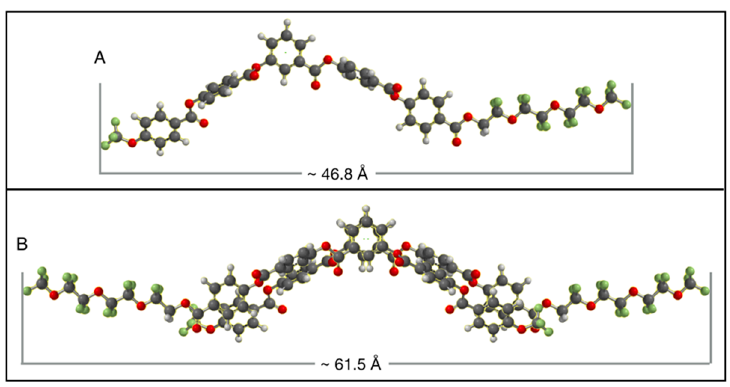
Figure 6. “Starting point” layer structure for W789 . ( A ) “fully extended” conformation of a single molecule of W789 ; ( B ) Pair of W586 molecules overlapping at the core.